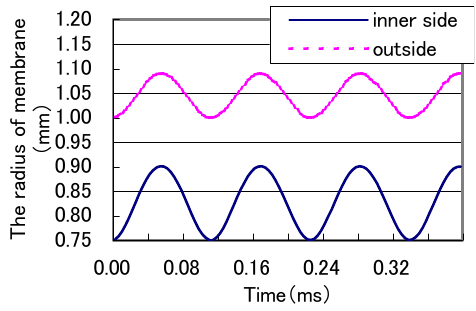
Fig. 11 Variation of membrane radius with time (injection pressure=0.05MPa, initial inner radius =0.75mm)